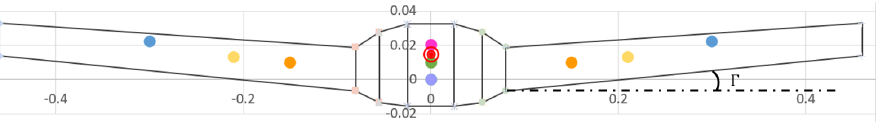
Figure 4. Front view of global tail-sitter